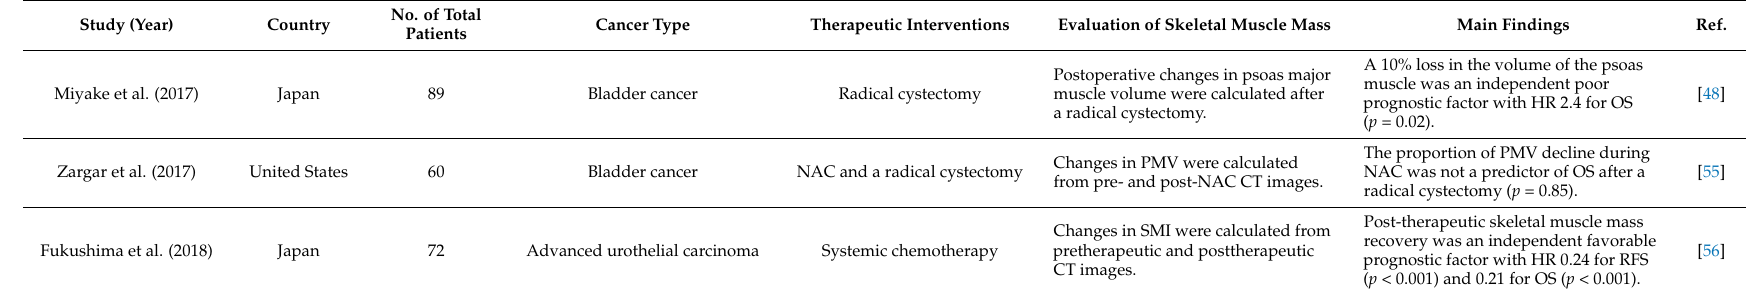
Table 2. Reported series of the prognostic role of changes in skeletal muscle mass in bladder cancer